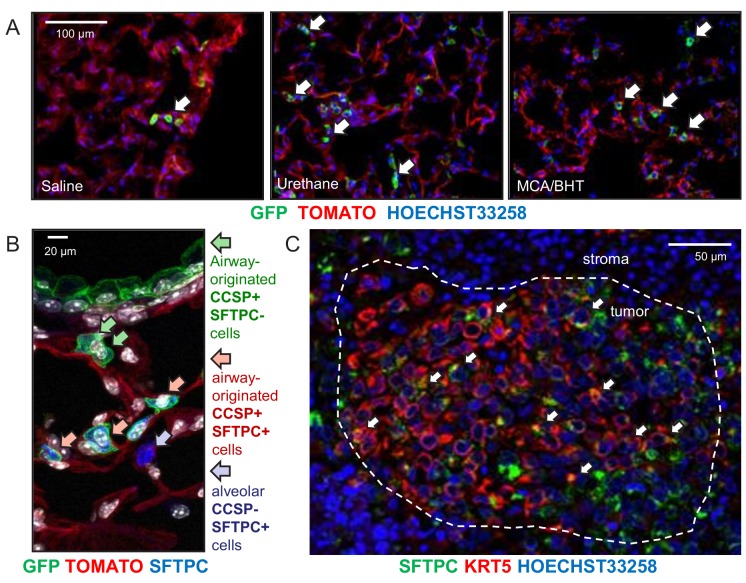
Expansion of airway cells in the tumor-initiated lung.(A) Non-neoplastic alveolar regions from lung sections of saline-, urethane (ethyl carbamate, EC)-, and 3-methyl-1,2-dyhydrobenzo[j]aceanthrylene/butylated hydroxytoluene (MCA/BHT)-treated GFP;CCSP.CRE mice at six months into treatment (n = 8 mice/group). Note the few GFP-labeled cells of saline-treated mice and their increased numbers in carcinogen-treated mice (arrows). See also Figure 3—figure supplements 1 and 2. (B) Juxtabronchial region from lung section of urethane-treated GFP;CCSP.CRE mouse at six months into treatment (n = 22) stained for the alveolar type II cell marker SFTPC. Arrows and legend indicate different phenotypes of extrabronchial GFP-labeled cells. See also Figure 3—figure supplements 3–5. (C) Merged high-power image of SFTPC and KRT5 co-staining of human lung adenocarcinoma (n = 10) shows significant co-localization of the two markers in a subset of tumor cells (arrows). See also Figure 3—figure supplement 6. CCSP, Clara cell secretory protein; SFTPC, surfactant protein C; KRT5, keratin 5.